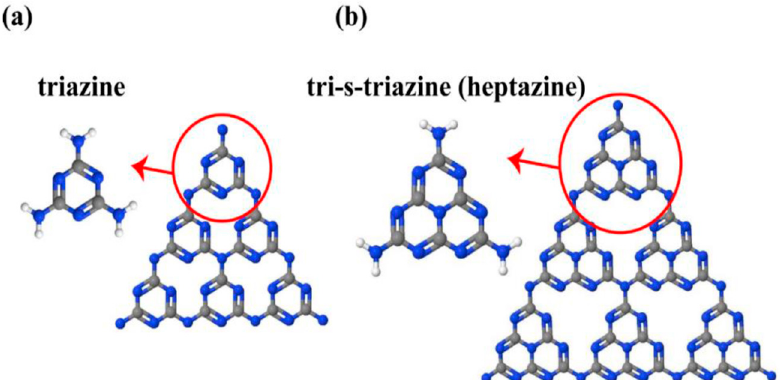
Figure 2. ( a ) Triazine and ( b ) tri-striazine (heptazine) structures of g-C 3 N 4 (blue, gray and white balls are nitrogen, carbon and hydrogen, respectively) [60].